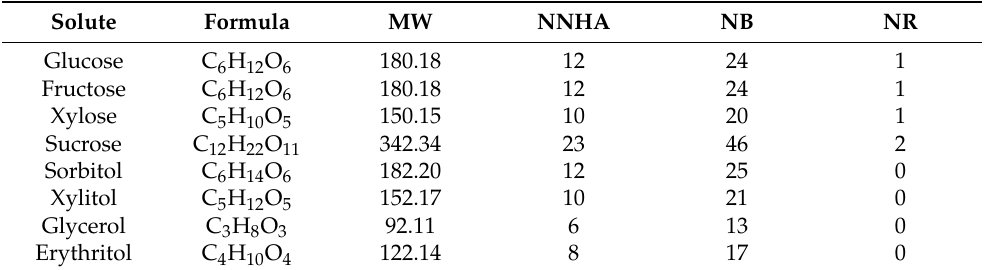
Table 3. Molecular properties of the solutes relevant to the calculation of theoretical descriptors (MW: molecular weight; NNHA: number of non-H atoms; NB: number of bonds; NR: number of